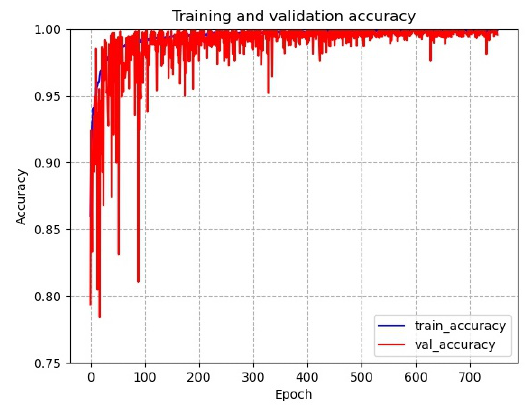
Figure 15. Accuracy of improved network for tool wear status diagnosis.